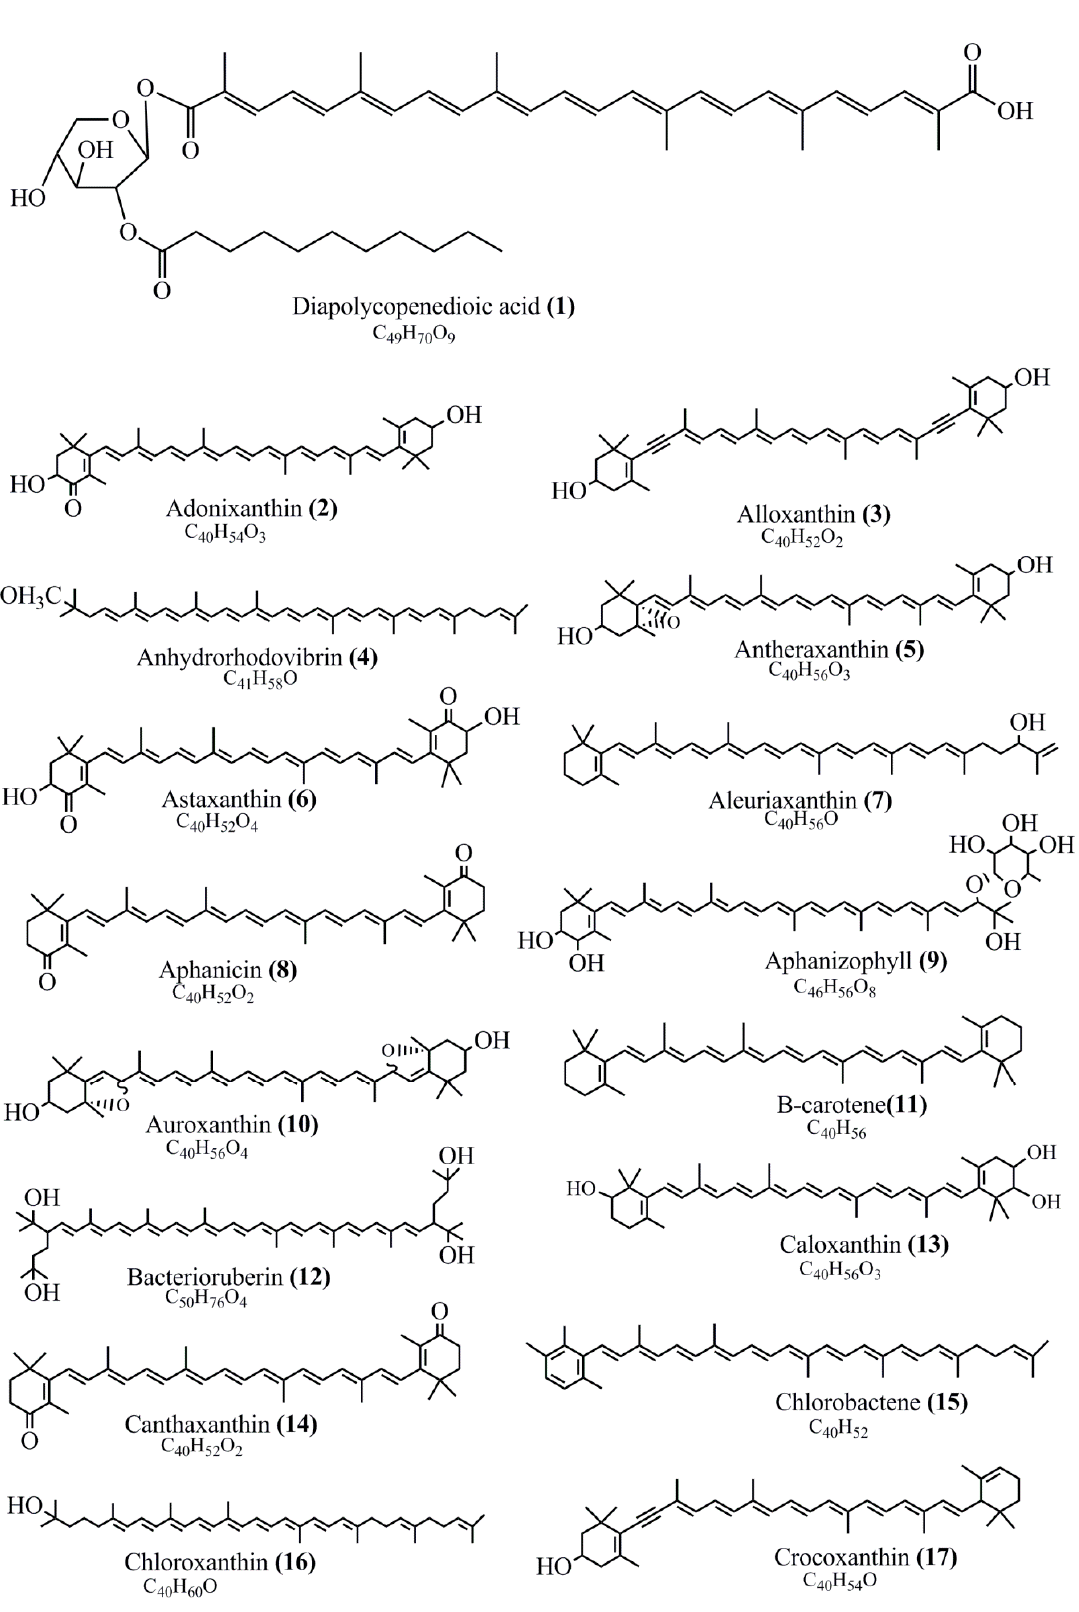
Figure 1. Chemical structures of various pigments. Figure 1.